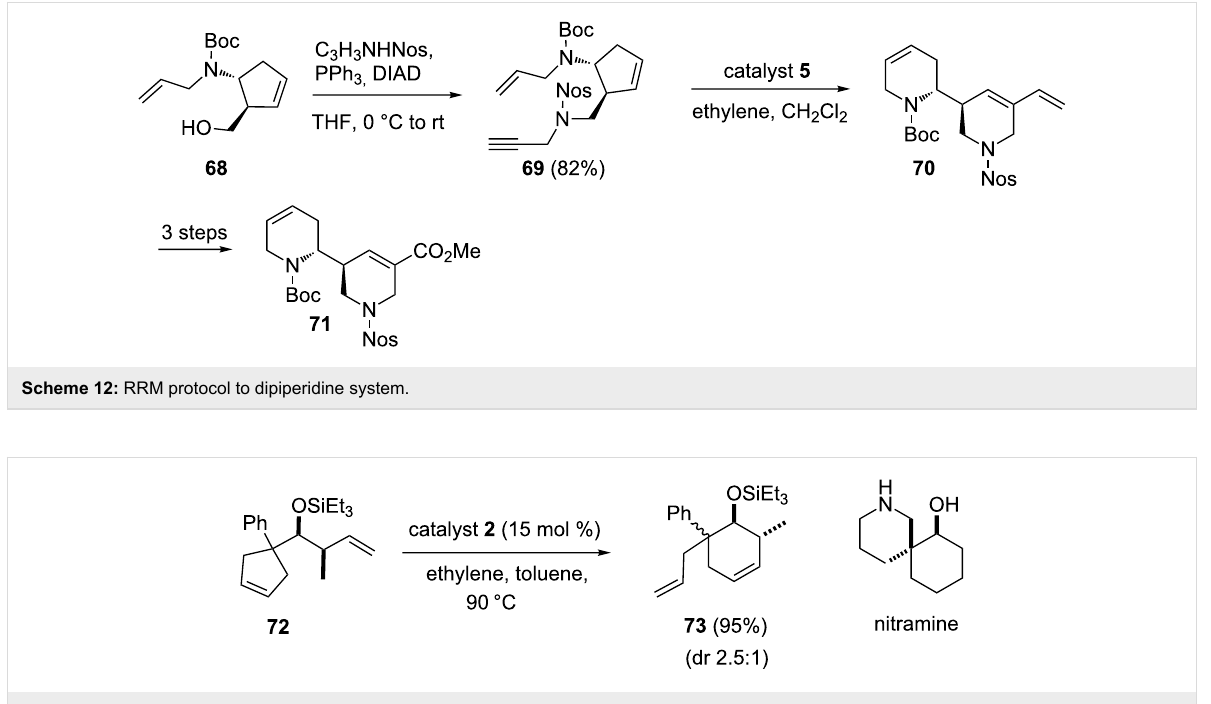
Scheme 13: RRM of cyclopentene system to generate the cyclohexene